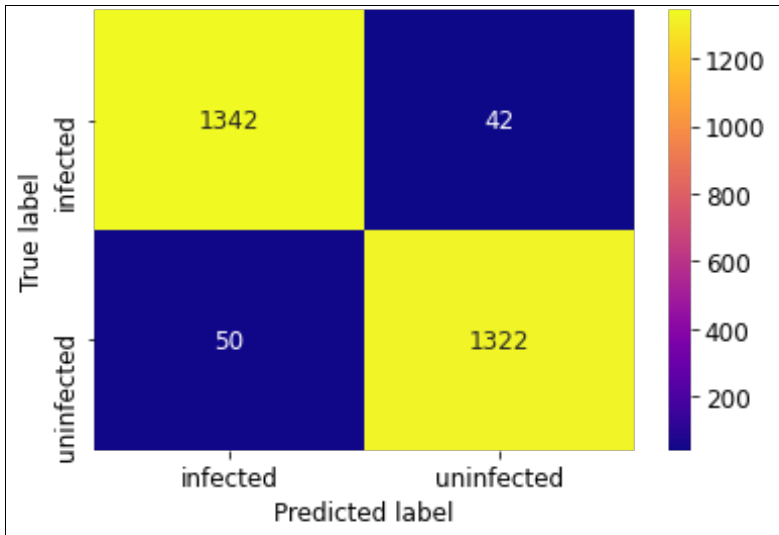
Figure 8. Confusion Matrix of MobileNetV2 model.